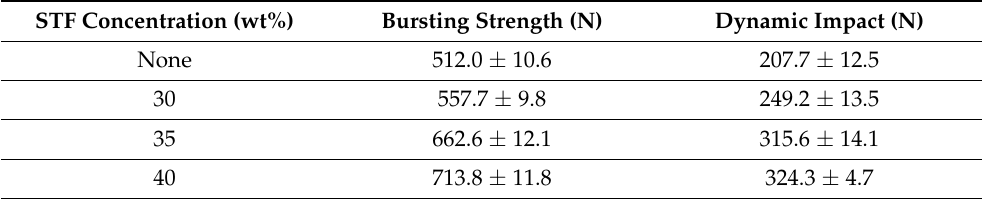
Table 3. Summary of bursting strength and dynamic impact